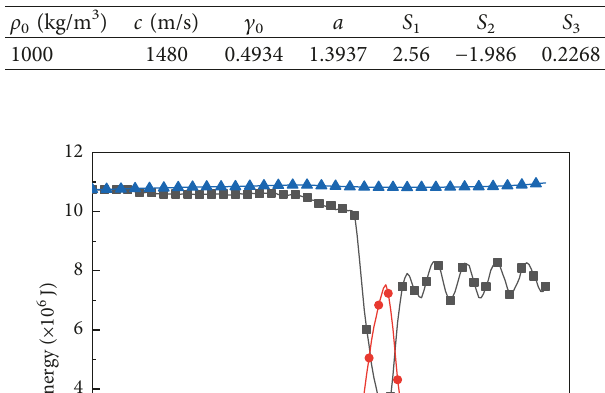
Table 2: Material parameters and coefficients in Gruneisen equation of state of water.